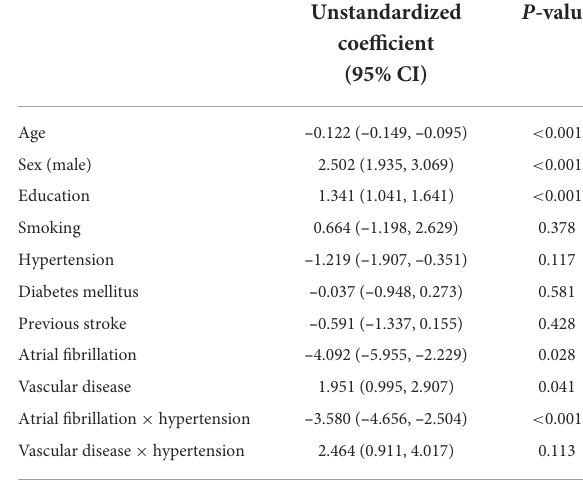
TABLE 2 Direct associations between predictors and cognitive function.